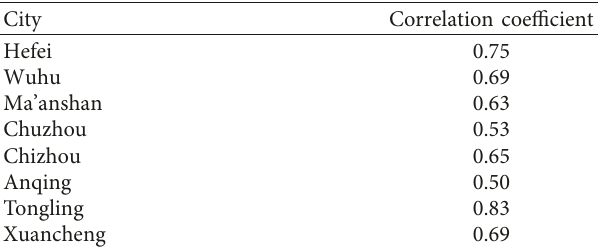
Figure 4: Comparison of OMI-retrieved tropospheric NO 2 columns and surface in situ concentrations for eight WCB cities: (a) Hefei; (b) Wuhu; (c) Ma’anshan; (d) Chuzhou; (e) Chizhou; (f) Anqing; (g) Tongling; (h) Xuancheng. Table 1: The Pearson correlation coefficients of OMI-retrieved tropospheric NO 2 columns and surface in situ concentrations for eight WCB